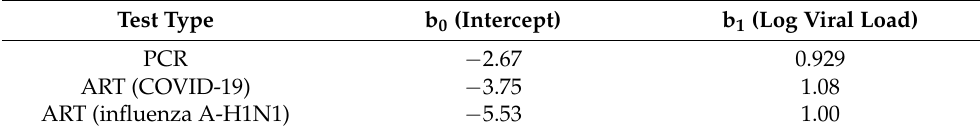
Table 2. The resulting curves are displayed in Figure 2, wherein test sensitivities (proportion detected) by log viral load are plotted for PCR (red), antigen for SARS-CoV-2 (orange) and antigen for influenza A-H1N1 (blue). Table 2. Logistic regression coefficients for test sensitivities against log viral load (in RNA copies/mL).